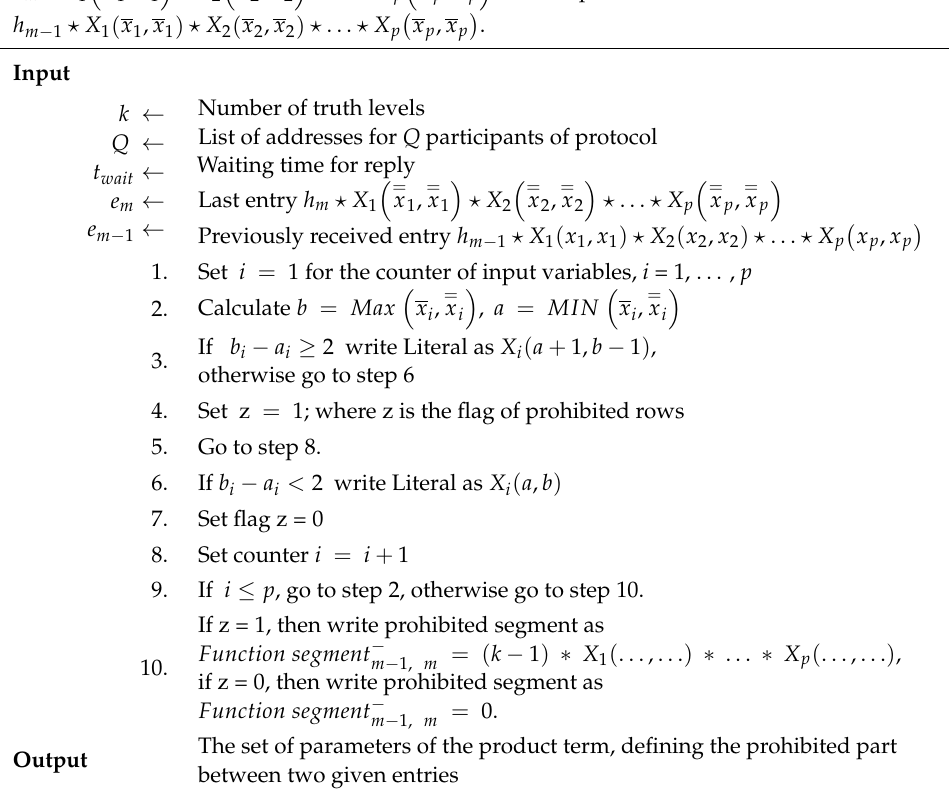
(cid:16) = (cid:17) = x p , x p and the previous one